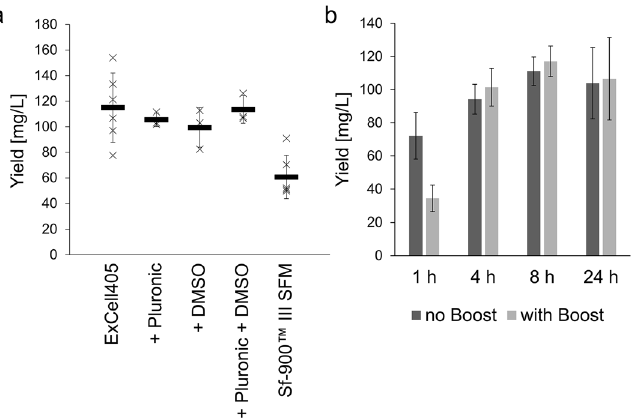
Figure 3. Effect of media and additives of the production of TUN219-2C1-hFc in High Five insect cells. ( a ) Comparison of production in different media (EX-CELL405 and Sf-900™ III SFM) and EX-CELL405 complemented with different supplements (0.1% Pluronic F68, 0.05% DMSO or both). ( b ) Evaluation of different time points for the first feeding after transfection with and without addition of 10% HyClone Cell Boost 6. All experiments were performed in quadruplicates; the standard deviation is